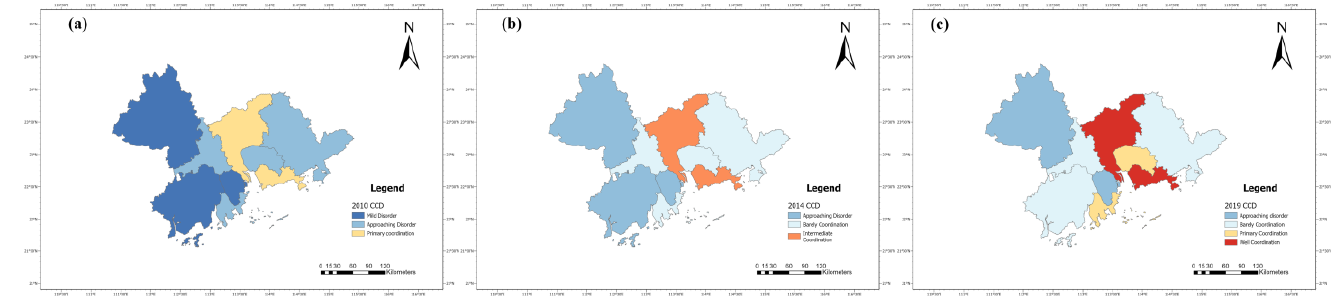
Figure 12. The CCD of the TEE system in nine cities in the PRD.